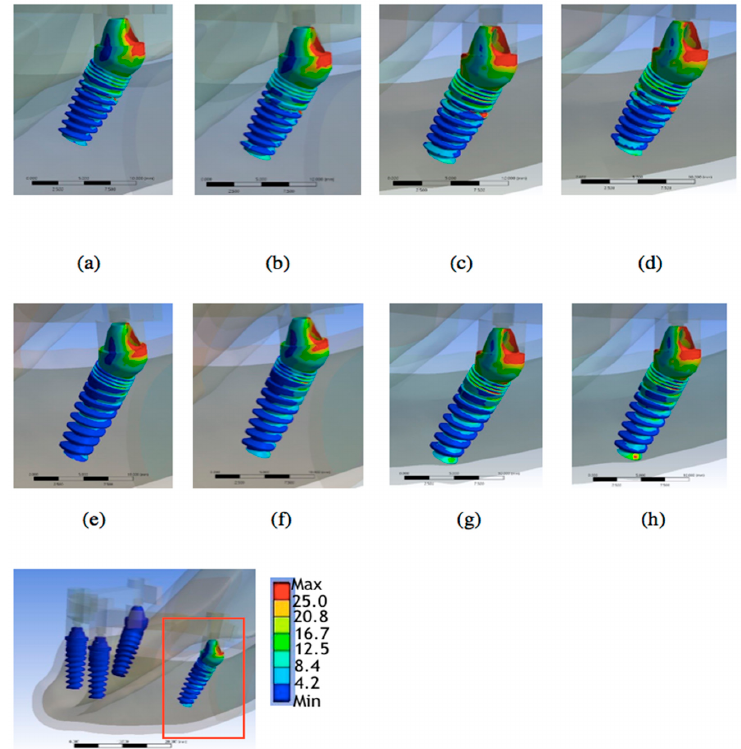
Figure 3. Dental implant with a high stress distribution in ( a ) Model 1, ( b ) Model 2, ( c ) Model 3, ( d ) Model 4, ( e ) Model 5, ( f ) Model 6, ( g ) Model 7, ( h ) Model 8.